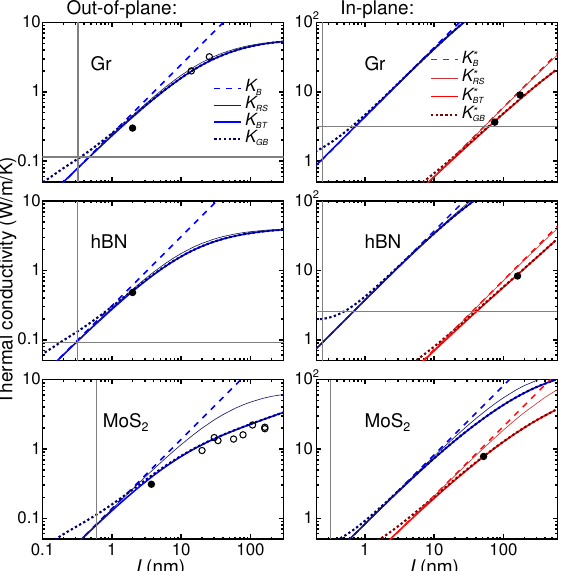
Figure 4. Modelling of the thermal conductivity of assembled flakes with size L along two possible transport directions (out-of-plane, K ⊥ , and in-plane, K (cid:107) ) for the three studied materials. Black solid dots are the measurements in this work of non-annealed samples (the abscissa is the average thickness of a single flake within the film), while open dots are from Refs. [20,38,39] (see main text). The lines correspond to various models labeled as B (ballistic), RS (resistance in series), BT (Boltzmann Transport), Generalized Boltzmann (GB), and are obtained assuming an “ideal” ( K , blue lines) or “dirty” ( K ∗ , red lines) interface among the flakes. Vertical and horizontal grey lines are defined in the